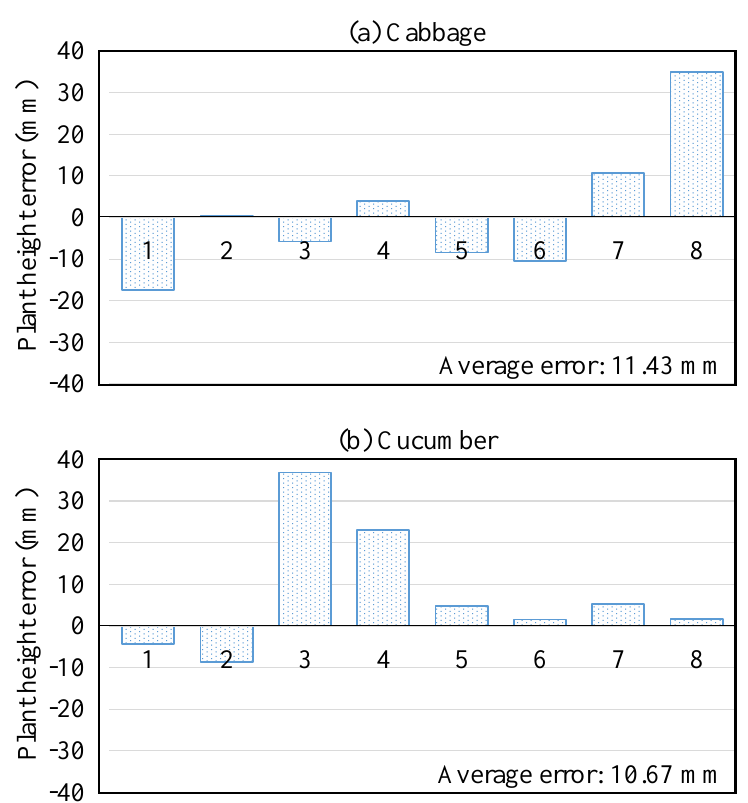
Figure 12. Errors of plant height (calculated by differentiating the ground truth from the estimated one) of the cabbage ( a ) and cucumber plants ( b ). Notice that plant height was not determined for tomato compound leaves, because these leaves were imaged individually and are parts of a plant.